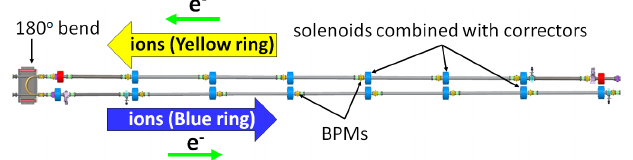
FIG. 3. The layout of the LEReC cooling sections.